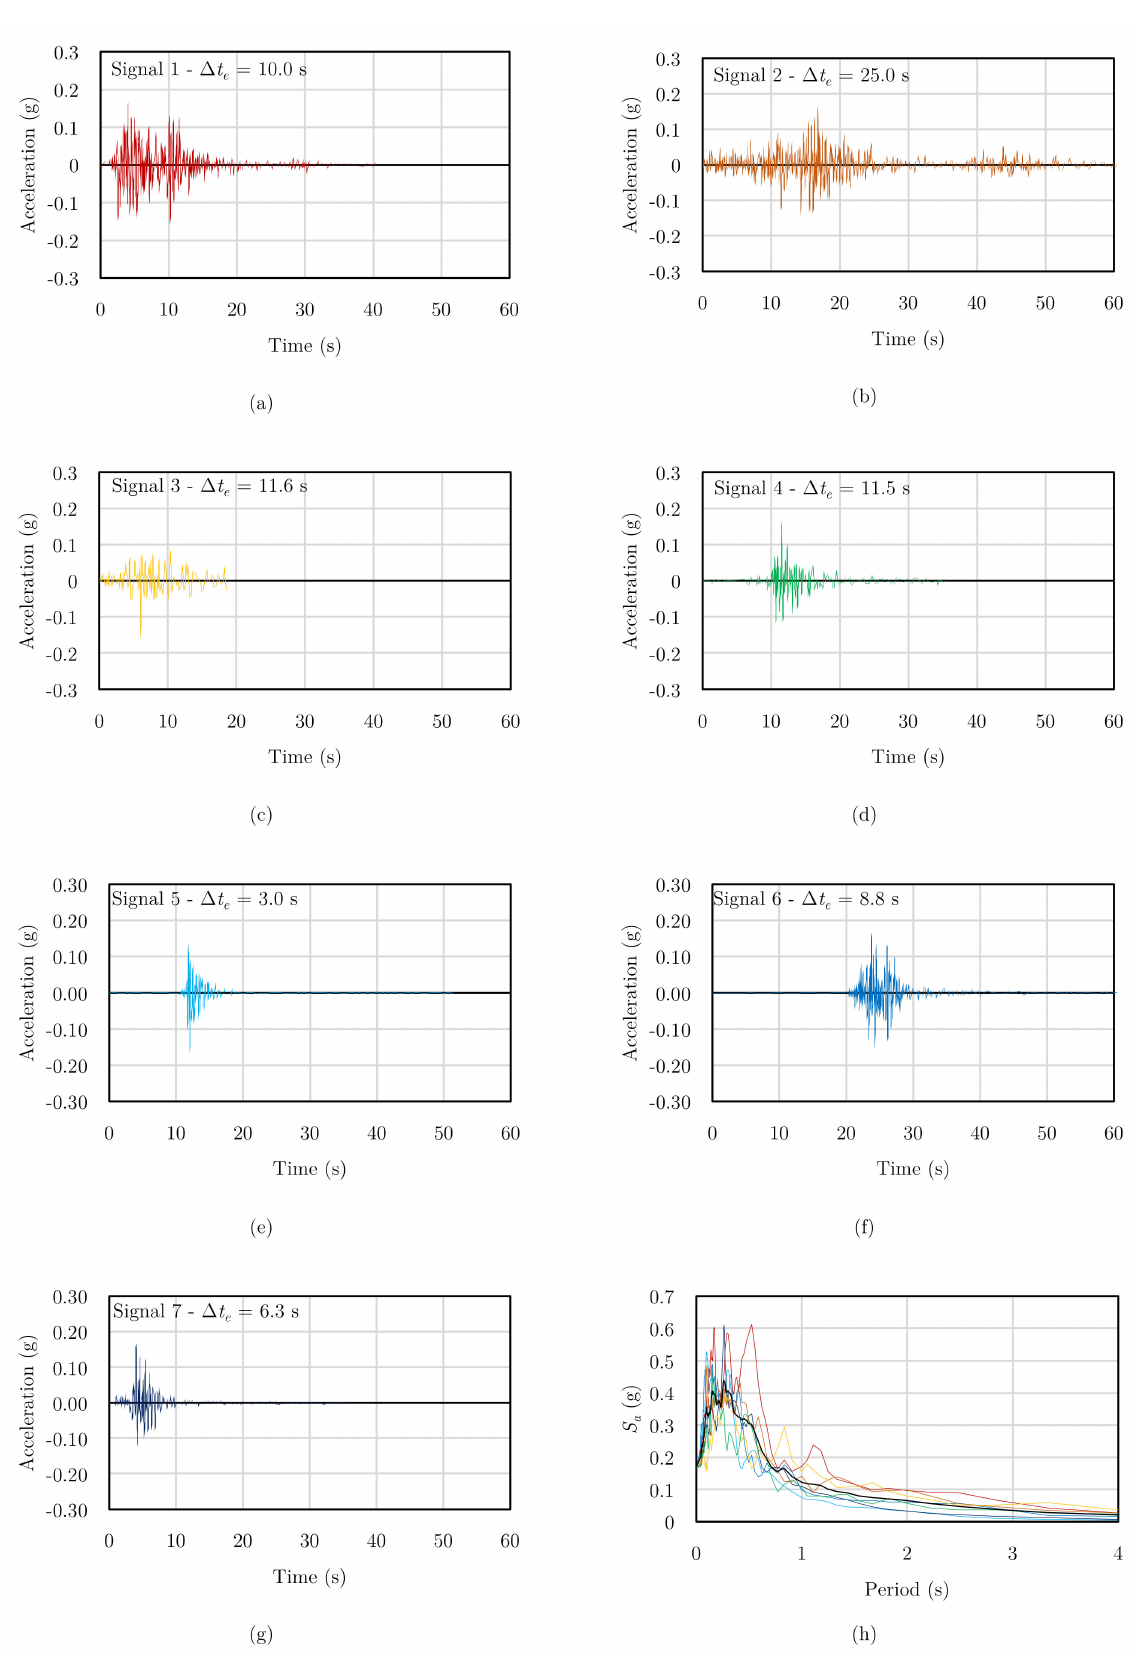
Figure 10. Tectonic seismic signals ( a – g ) and their average response spectrum ( h , depicted in black) [53] adopted for the numerical analyses on building